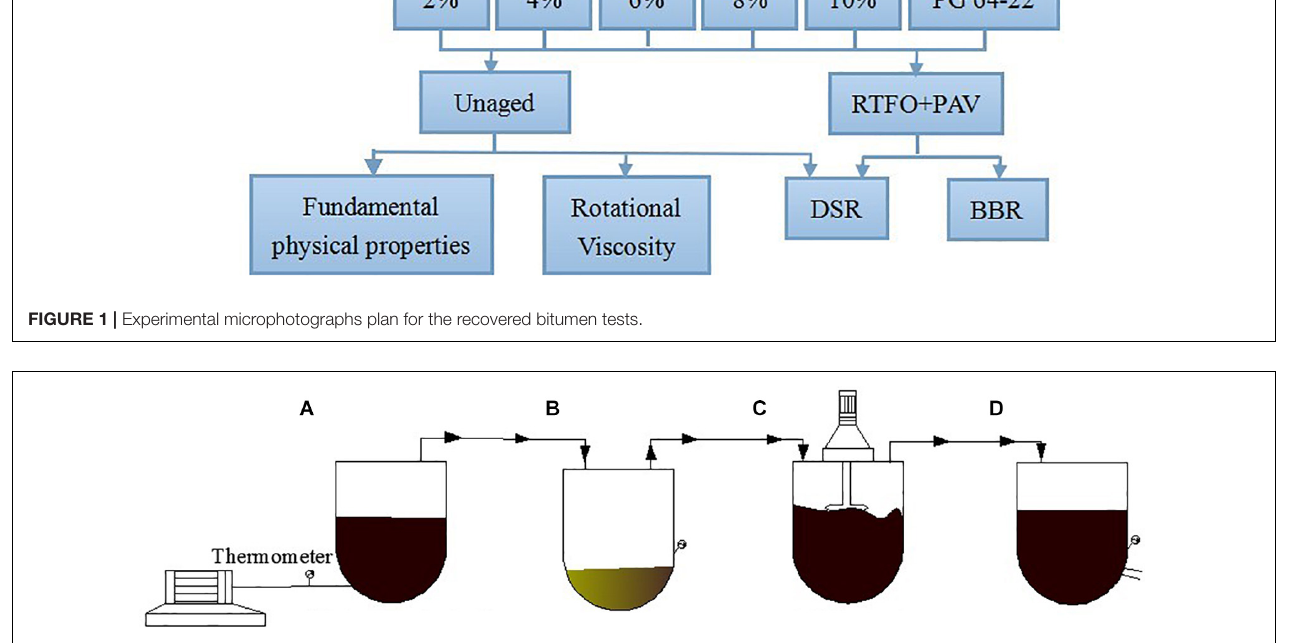
FIGURE 2 | The recycling process of aged bitumen. (A) Preheating device for aged asphalt; preheating temperature 135 ◦ C. (B) Regenerative storage equipment; storage temperature 25 ◦ C. (C) High speed shear mixer; mixing speed was 1,000 rpm for 1 h. (D) Static device of recycled asphalt; static temperature 135 ◦ C.